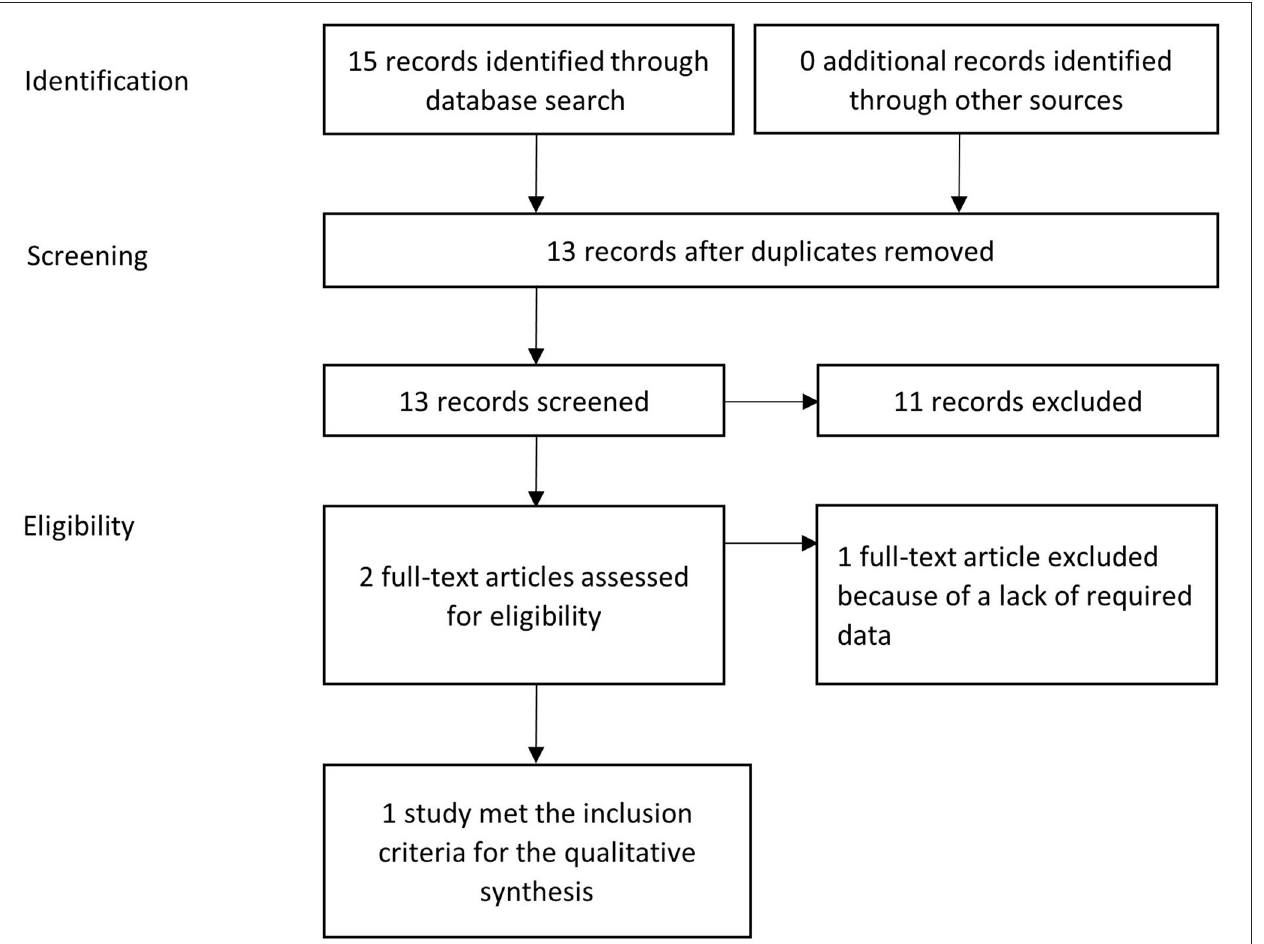
FIGURE 1 | PRISMA flow diagram: systematic identification and selection of publications; example for ampicillin in